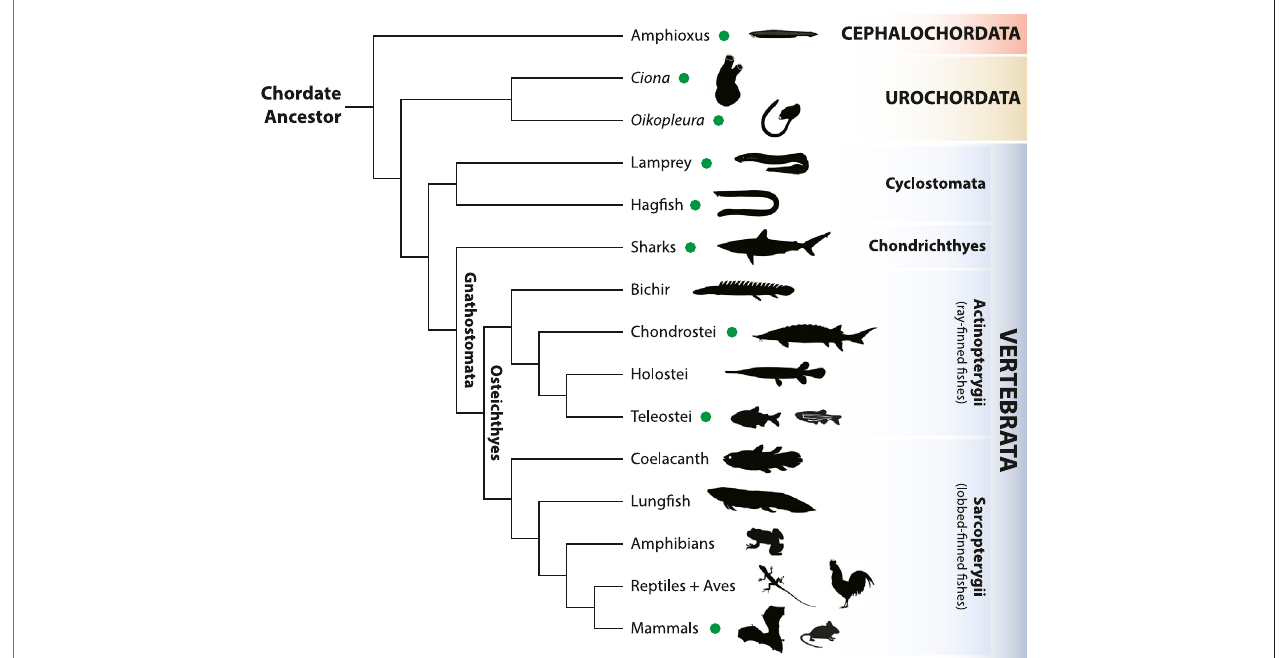
FIGURE 1 | Simpli fi ed phylogenetic tree of chordates (vertebrates, urochordates and cephalochordates). Models used in this Research Topic are marked with a green dot. Animal icons are from http://phylopic.org/ under a Creative Commons license.